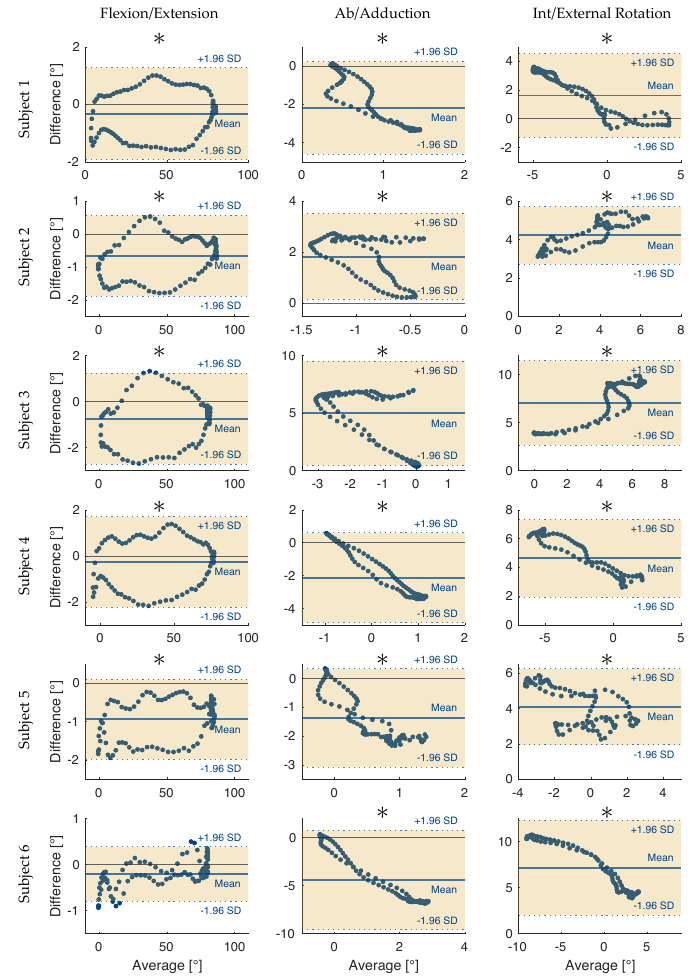
Figure A3. Bland-Altman plots for sit-to-stand-to-sit. Differences between simulator- and IMU-based estimates were plotted against the average of the two measures. Shaded areas denote two-tailed 95% confidence intervals while dotted blue lines represent limits of agreement and solid blue lines show the mean difference. Each row corresponds to a different subject; each column to a different plane of rotation. Inclusion of an asterisk indicates the assumption of normality was not